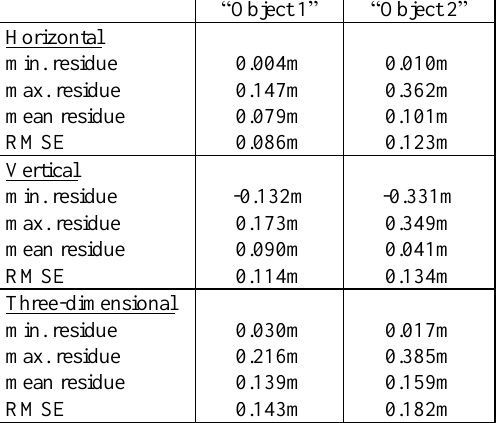
Table 2. Results of absolute accuracy assessment.